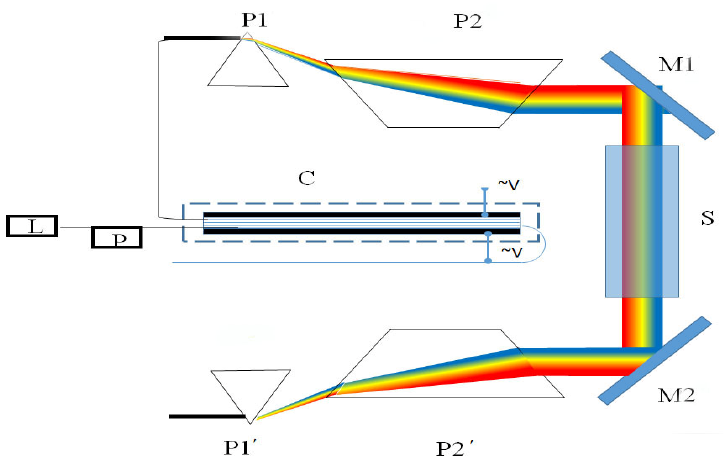
Figure 3. Overview of the compressor setup P1, P2, P1 ′ , and P2 ′ are four prisms, L is a pulsed laser, P is a pump source, C is a capacitor M1 and M2 are mirrors and S is a slab subjected to a DC electric field .